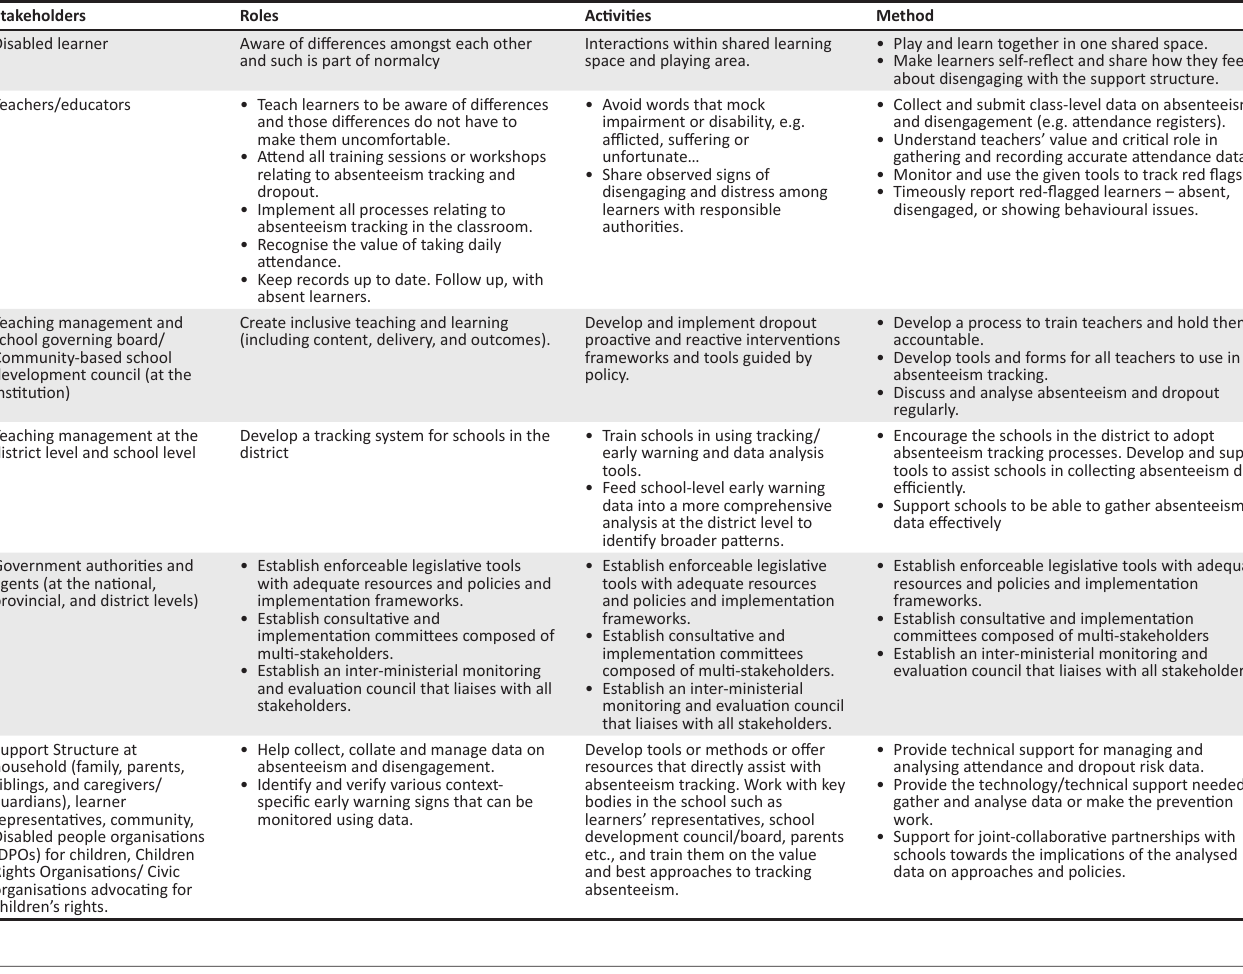
TABLE 2: Roles of stakeholders in inclusive education for the educational success of disabled children. Stakeholders